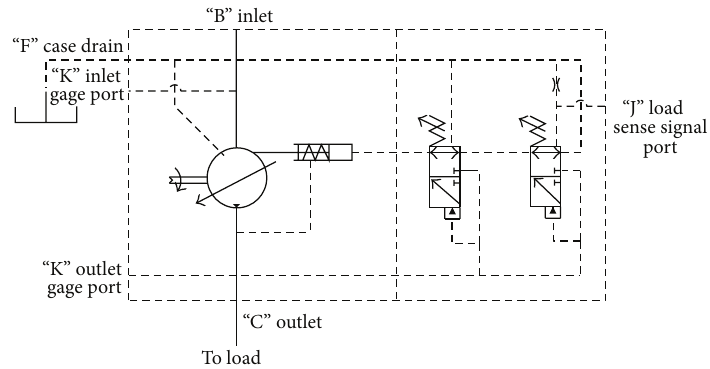
Figure 2: Hydraulic circuit of the mechanical regulator of the VDAPP.